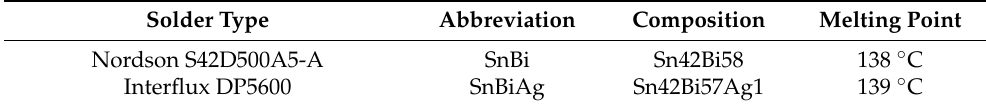
Table 1. Overview of used solder materials.